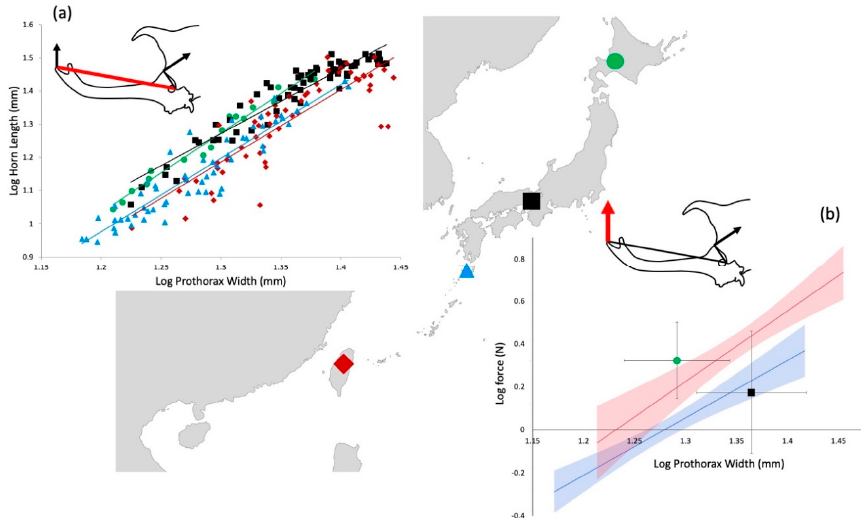
Figure 2. Comparison of scaling of horn length ( a ; red line in drawing) and force production ( b ; red arrow in drawing) among populations of Trypoxylus dichotomus males. Both variables are compared across prothorax width. The background is an outline of eastern Asia with sampling locations indicated with colored shapes. Colors also correspond to data in graphs. Green circles = Hokkaido, Japan. Black squares = Kyoto, Honshu, Japan. Blue triangles = Yakushima, Japan. Red diamonds = Puli, Taiwan. In ( a ) slopes are not different, but Hokkaido and Kyoto beetles have relatively longer horns for their body sizes (ANCOVA F 3,200 = 20.7, p > 0.001). In ( b ) Muscles in the prothorax (black arrow in inset drawing) exert force through a simple lever, inserting on the dorsal/caudal surface of the head and rotating the head and horn around a fulcrum just behind the eye. Only Taiwan and Yakushima populations have a relationship between this measured force and body size. For these, a least squares regression line is shown with shaded areas indicating the 95% confidence intervals of slope. Taiwan beetles produce higher forces for a given body size than Yakushima beetles (ANCOVA F 2,117 = 102.3, p < 0.001). Because there is no relationship between force and body size in Kyoto or Hokkaido beetles, populations are indicated as means ± 1 SD (standard deviation) for measured forces and body sizes. Hokkaido beetles produced higher average forces than Kyoto beetles (ANOVA F 1,82 = 4.6, p = 0.03), in spite of having a smaller average body size (ANOVA F 1,82 = 27.1, p < 0.001). The two populations with relatively shorter horns for their body sizes, Taiwan and Yakushima, had positive relationships between body size (prothorax width) and force (Yakushima, F 1,58 = 47.5, p < 0.001, Taiwan, F 1,58 = 30.7, p < 0.001) and between horn length and force (Yakushima, F 1,58 = 35.8, p < 0.001, Taiwan, F 1,58 = 23.3, p < 0.001; Figure 2b). In contrast, the two populations with relatively longer horns, Kyoto and Hokkaido, showed no relationship between body size and force (Kyoto F 61 = 1.71, p = 0.44; Hokkaido F 17 = 2.48, p = 0.14). The Taiwan population produced higher forces for a given body size than the Yakushima population (ANCOVA F 2,117 = 102.3, p < 0.001). Hokkaido beetles produced higher average forces than Kyoto beetles (ANOVA F 1,82 = 4.6, p = 0.03; Figure 2b). In the Taiwan population, the force we measured was similar to the force required to dislodge a beetle [14] across a range of body sizes (Figure 3). The force required to dislodge beetles was not measured in other populations.